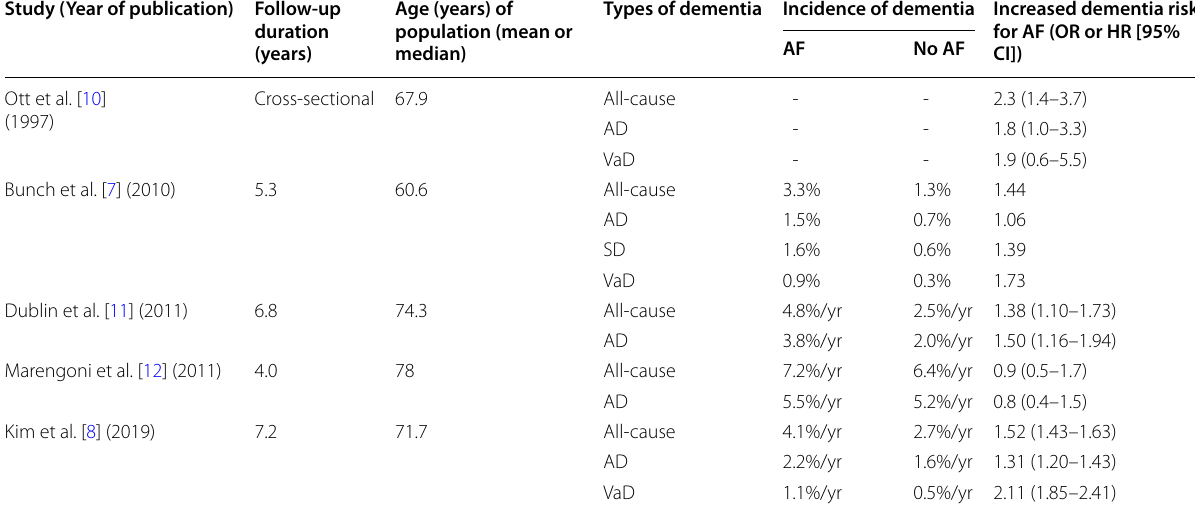
AD Alzheimer’s disease, AF atrial fibrillation, CI confidence interval, HR hazard ratio, OR odds ratio, SD senile dementia, VaD vascular dementia